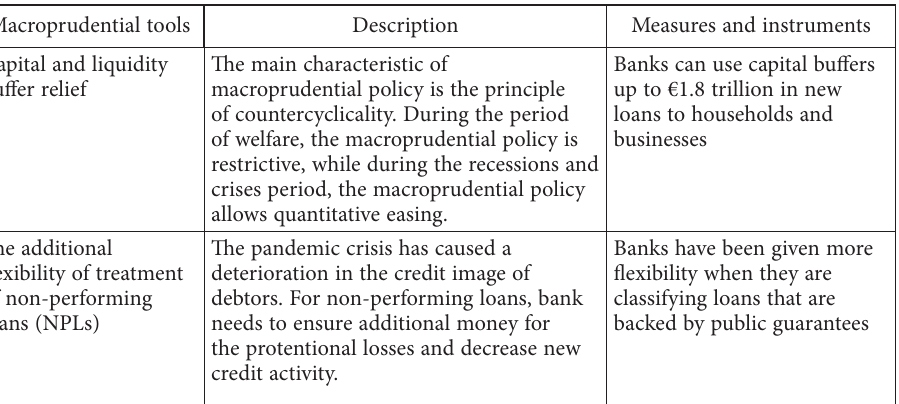
Table 1. The macroprudential tools of European Central Bank for euro area countries during corona crisis (source: authors according to European Central Bank,